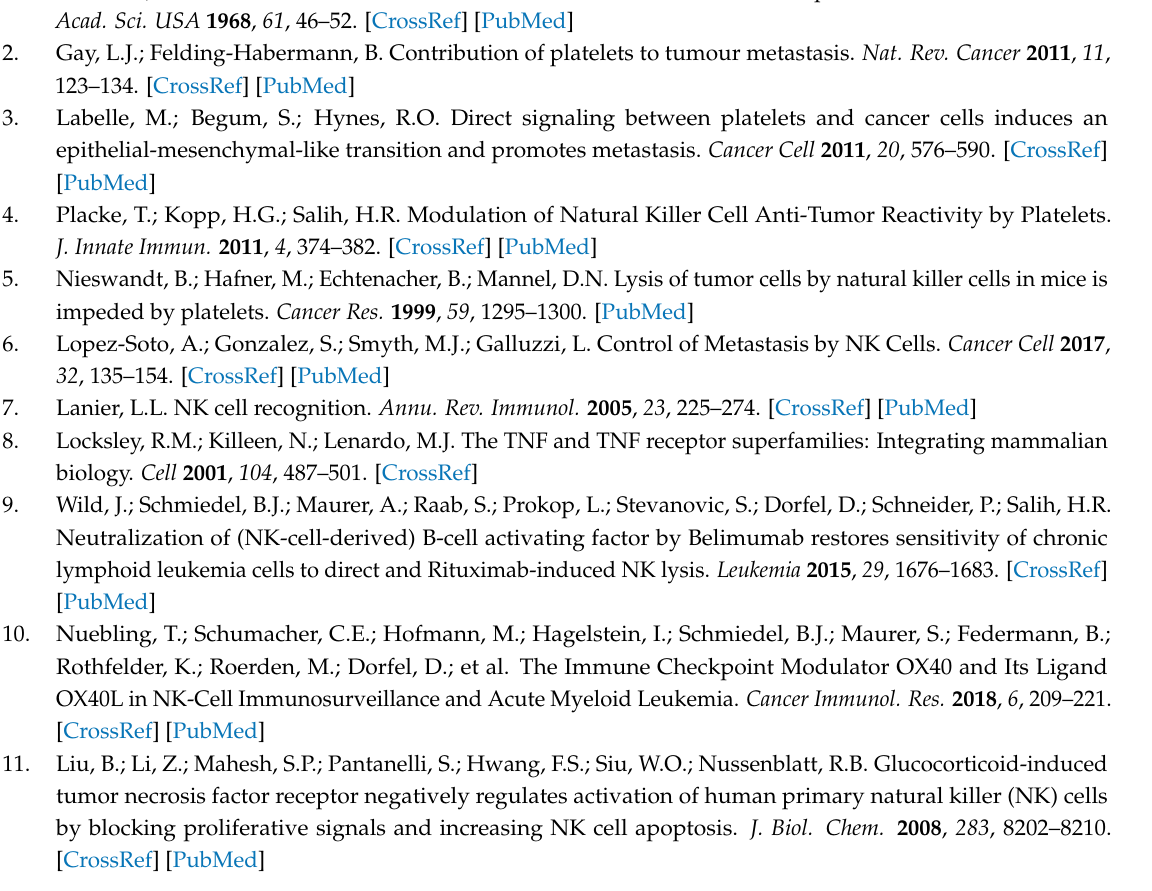
Figure S1: rhRANKL and NK cell/platelet-derived factors do not affect survival/proliferation of tumor cells, Figure S2: Denosumab does not affect NK cell reactivity via its Fc